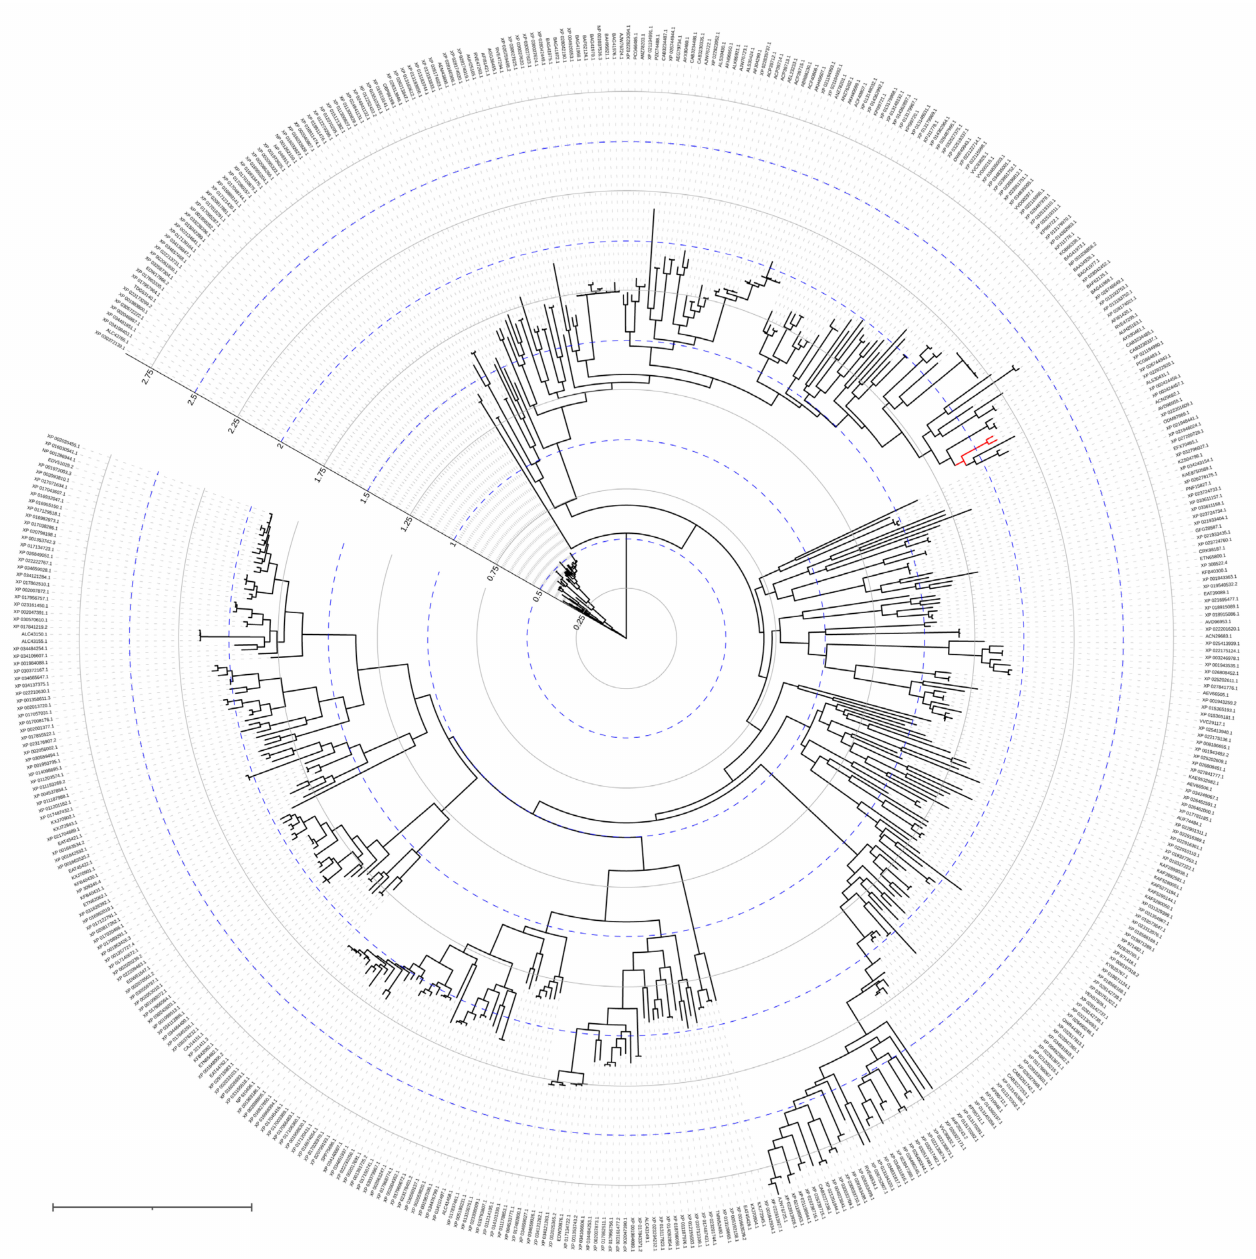
Figure 13. Phylogenetic tree of ALP and its homologous enzymes (down to 46% identity). The tree was built as previously with UniProt A0A2W1BMI5 as a reference sequence. Enzymes having high (90–100%) identity are highlighted with